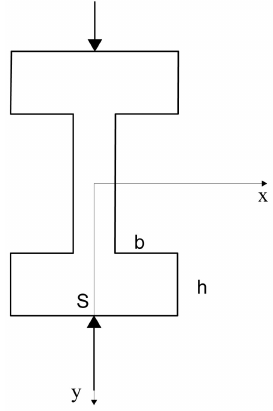
Figure 2. The overall cellular structure under load.